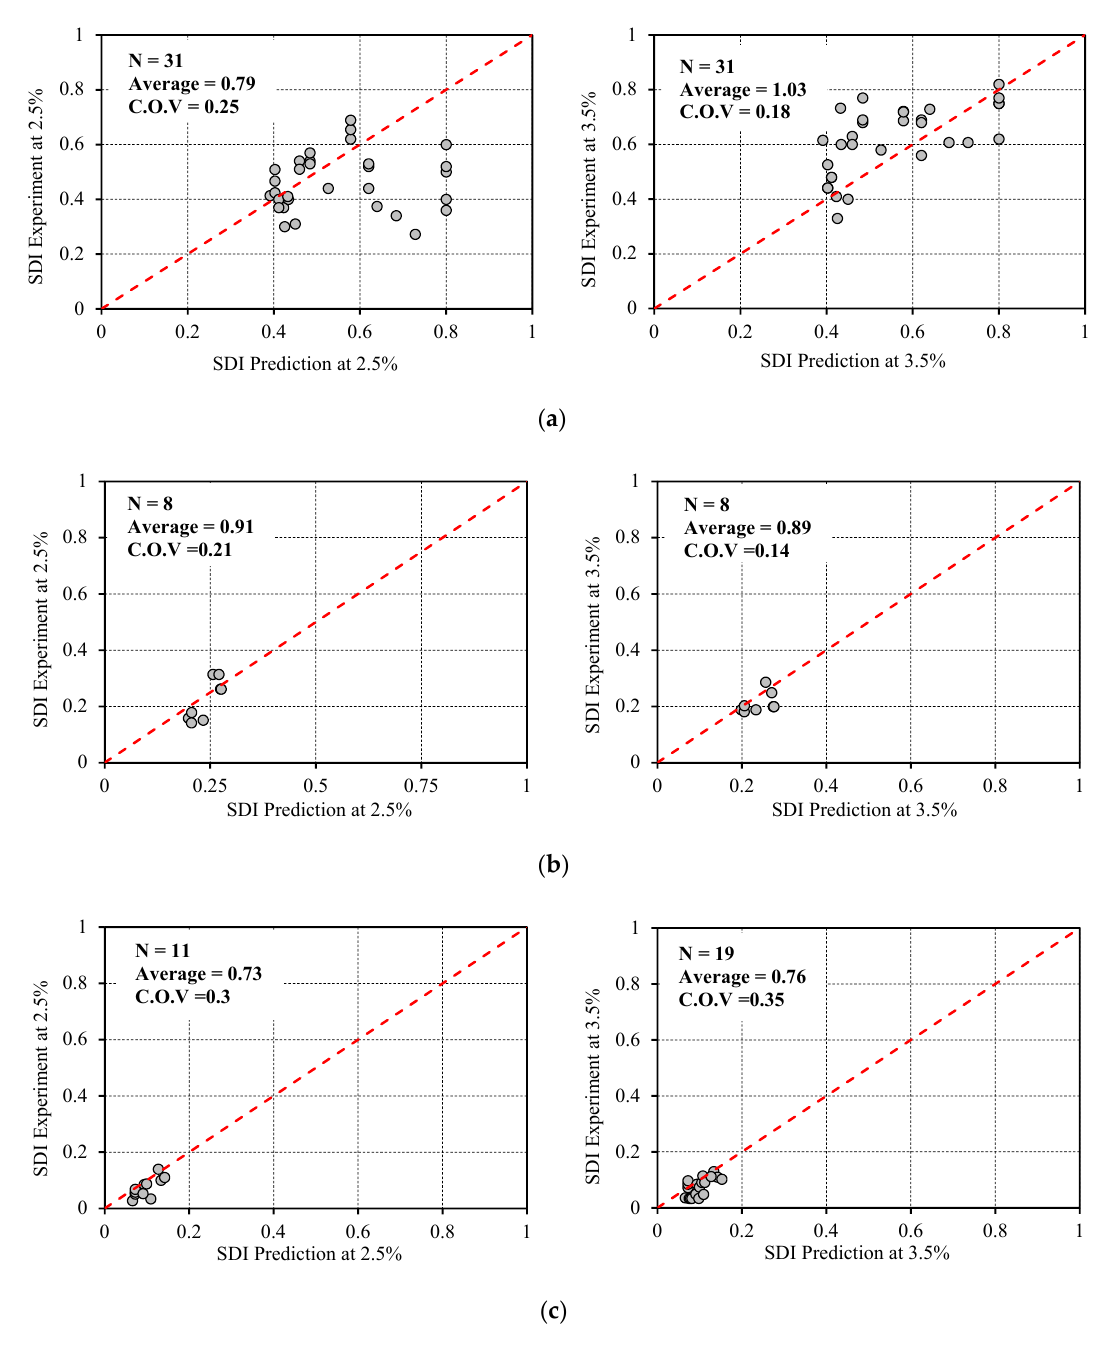
Figure 21. Experimental shear deformation index (SDI) versus the SDI predicted by proposed equations: ( a ) J-mode predicted by Equation (3); ( b ) BJ-mode predicted by Equation (4); and ( c ) B-mode predicted by Equation (5).